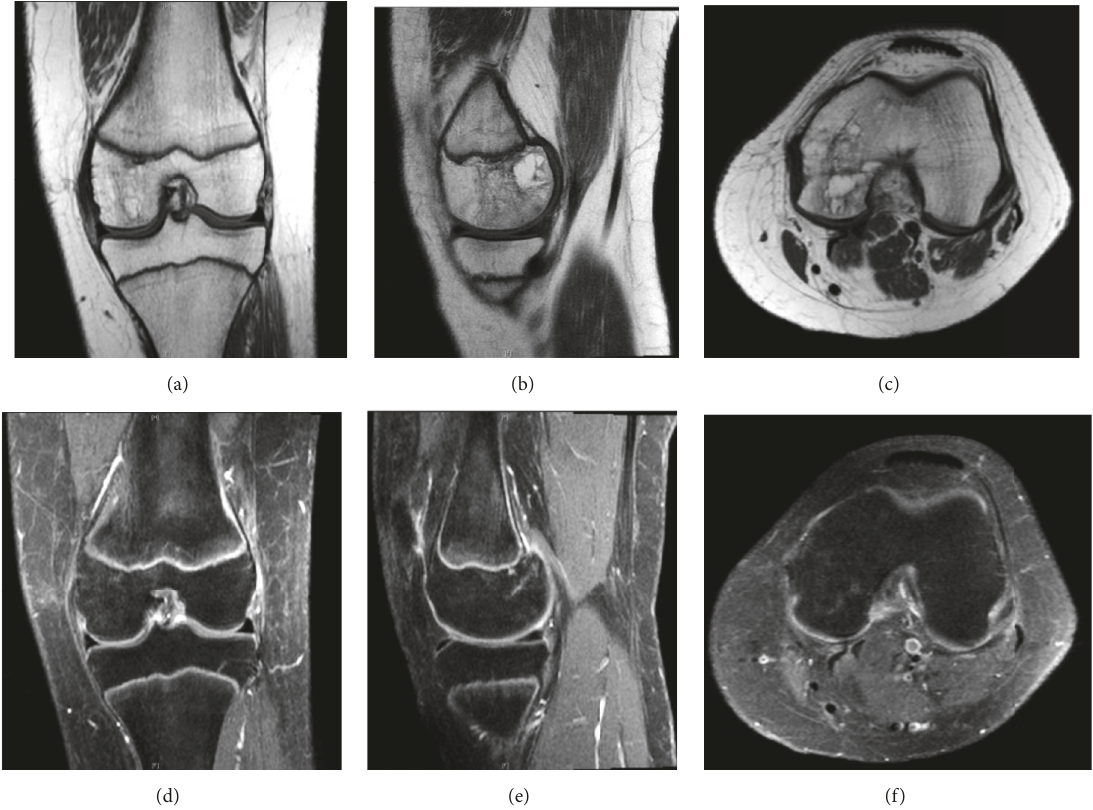
Figure 9: Magnetic resonance images (MRI): T1 coronal, sagittal, axial views (a, b, c) and T1 fat saturated w/contrast coronal, sagittal, axial views (d, e, f) of the left knee after completion of chemotherapy, October 2010. Near complete resolution of